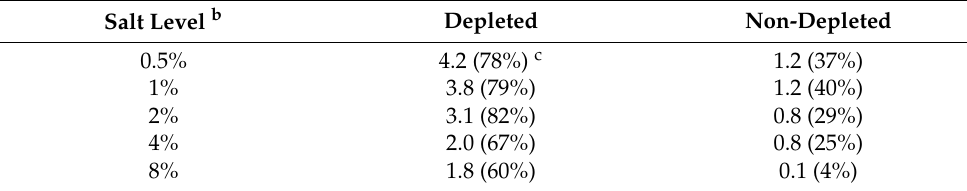
Table 1. 2 hr preference for salty food in sodium-depleted and non-depleted rats a